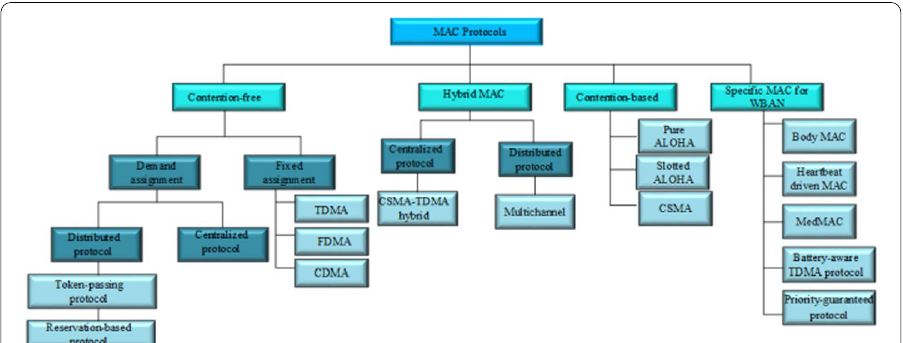
Fig. 2 Classification of MAC schemes for the WBAN‑enabled IoT